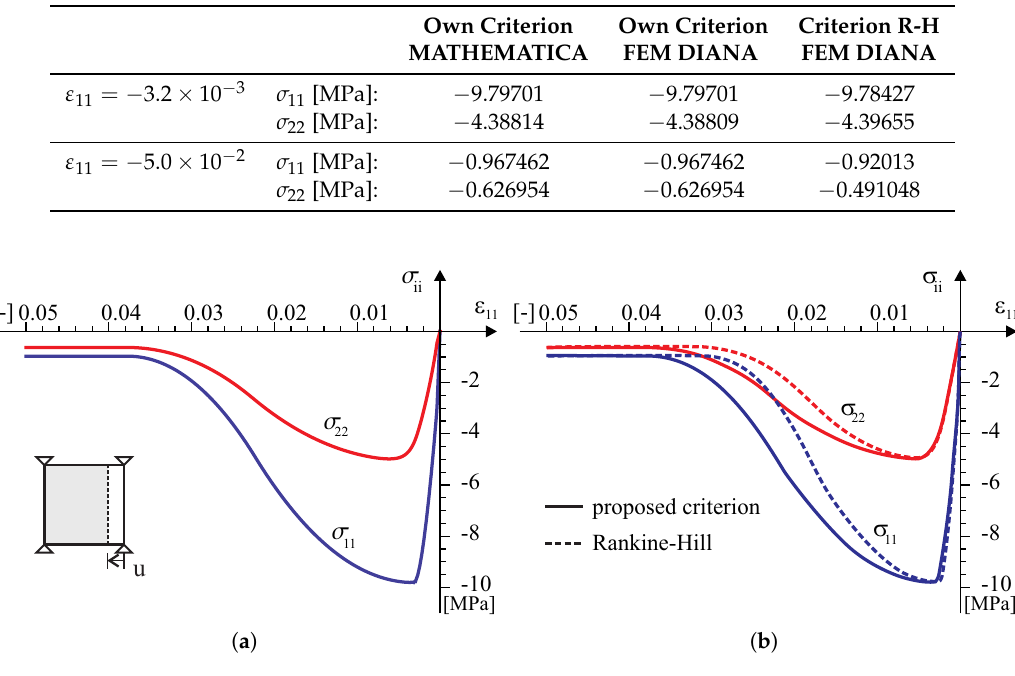
Figure 10. A homogeneous strain field ε 11 < 0 and ε 22 = 0 single element test results: ( a ) symbolic computation by MATHEMATICA [40], ( b ) FEM analysis in TNO DIANA